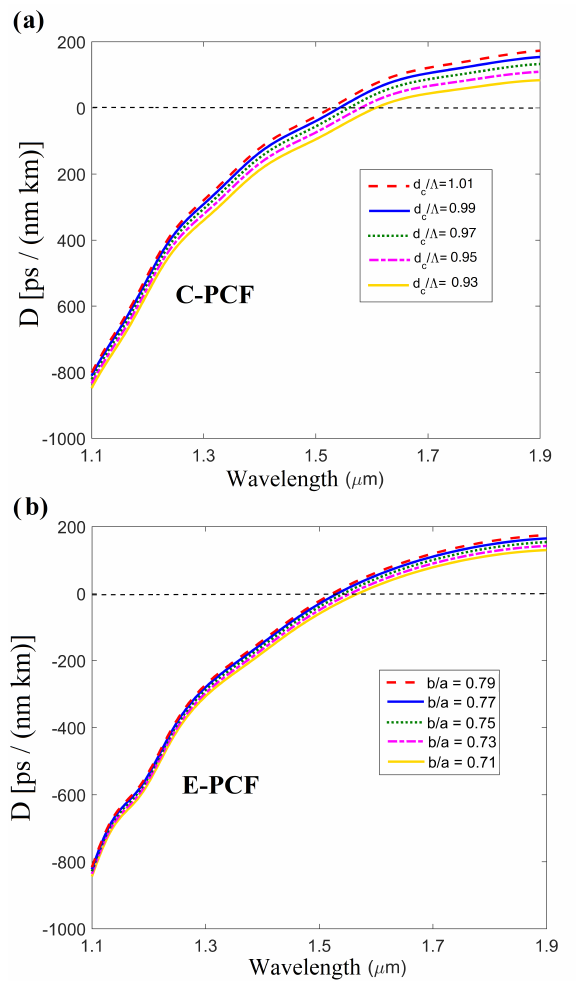
Figure 3. Dispersion of ( a ) circular-core fiber (C-PCF) and ( b ) elliptical-core fiber (E-PCF) with different core dimensions as a function excitation wavelength. The C-PCF parameters are: d = 0.692, Λ = 0.867, and E-PCF parameter is a = 1 µ